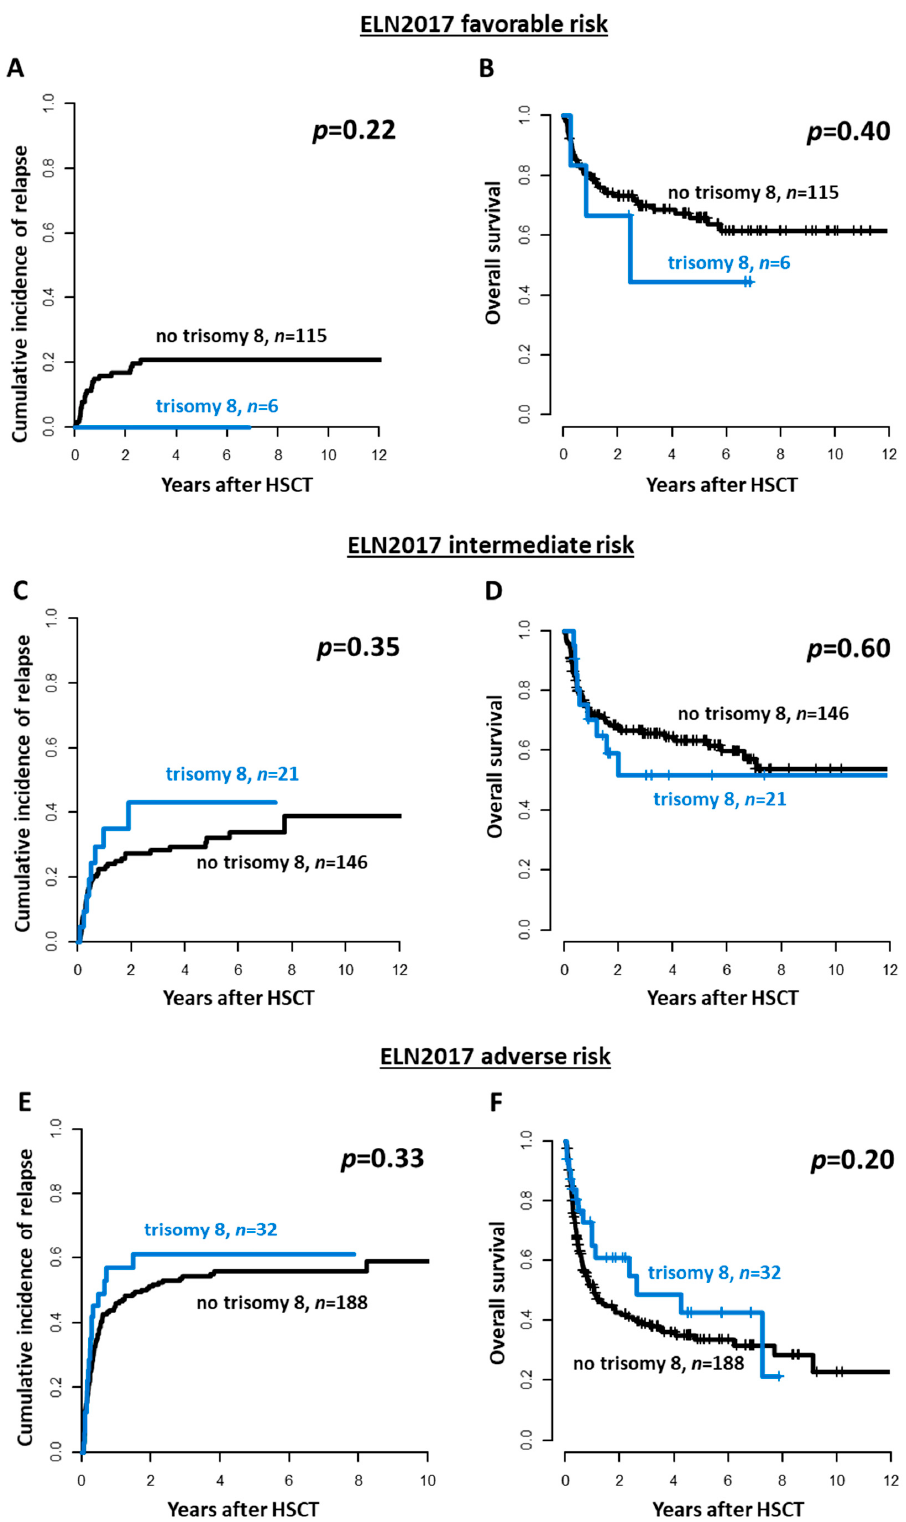
Figure 2. Outcomes of AML patients undergoing allogeneic hematopoietic stem cell transplantation (HSCT) within the three ELN2017 genetic risk groups according to the presence or absence of a trisomy 8 (trisomy 8 vs. others). ( A ) Cumulative incidence of relapse, and ( B ) Overall survival in patients with favorable ELN2017 risk ( n = 121). ( C ) Cumulative incidence of relapse, and ( D ) Overall survival in patients with intermediate ELN2017 risk ( n = 167). ( E ) Cumulative incidence of relapse, and ( F ) Overall survival in patients with adverse ELN2017 risk ( n =